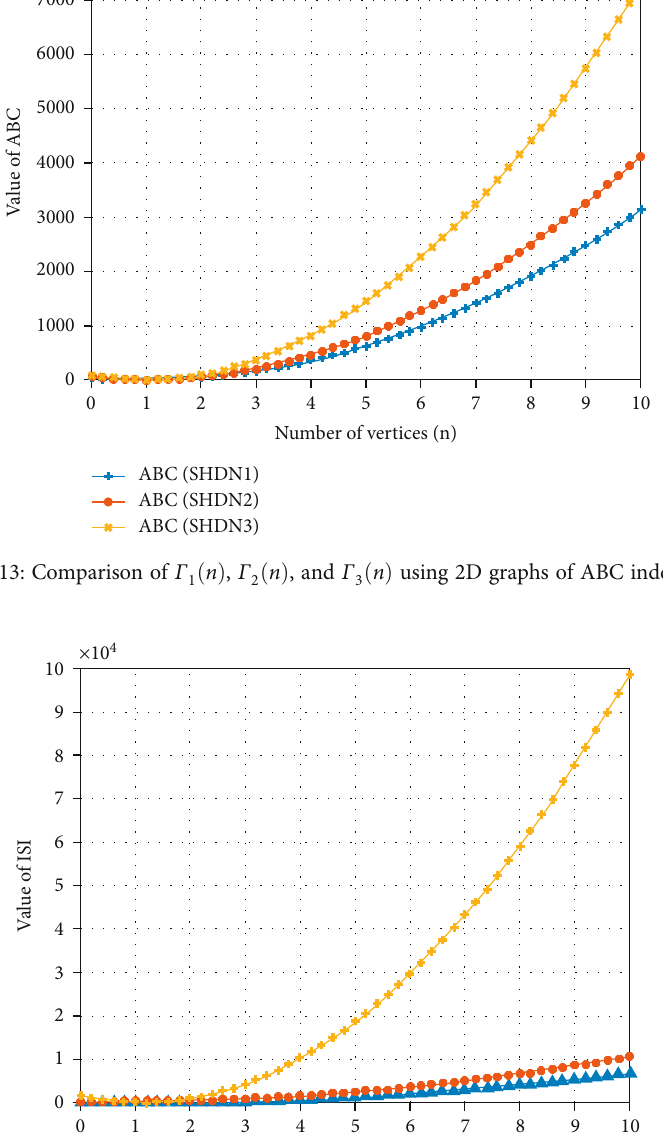
Figure 14: Comparison of Γ